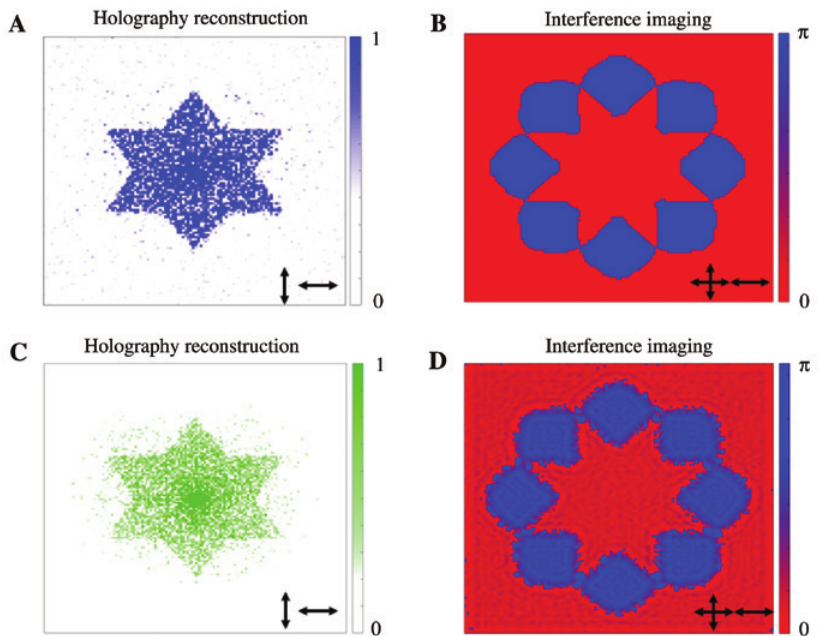
Figure 5: Numerical verification of hybrid encryption holography and phase interference imaging. (A, C) Holography reconstruction under amorphous state with far-field reconstruction and FDTD, respectively. (B, D) Interference imaging under crystalline state with far-field reconstruction and FDTD, respectively. Black arrows indicate output/input